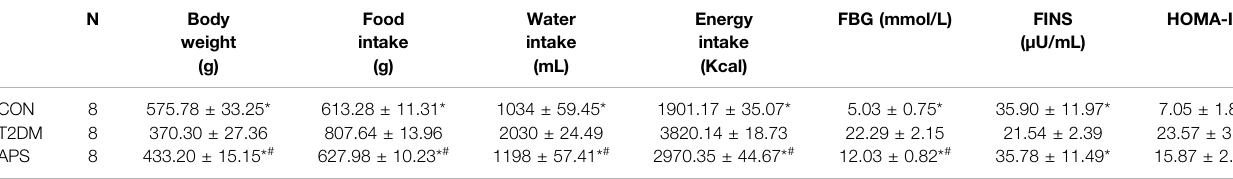
TABLE 2 | Daily indicators of experimental rats.